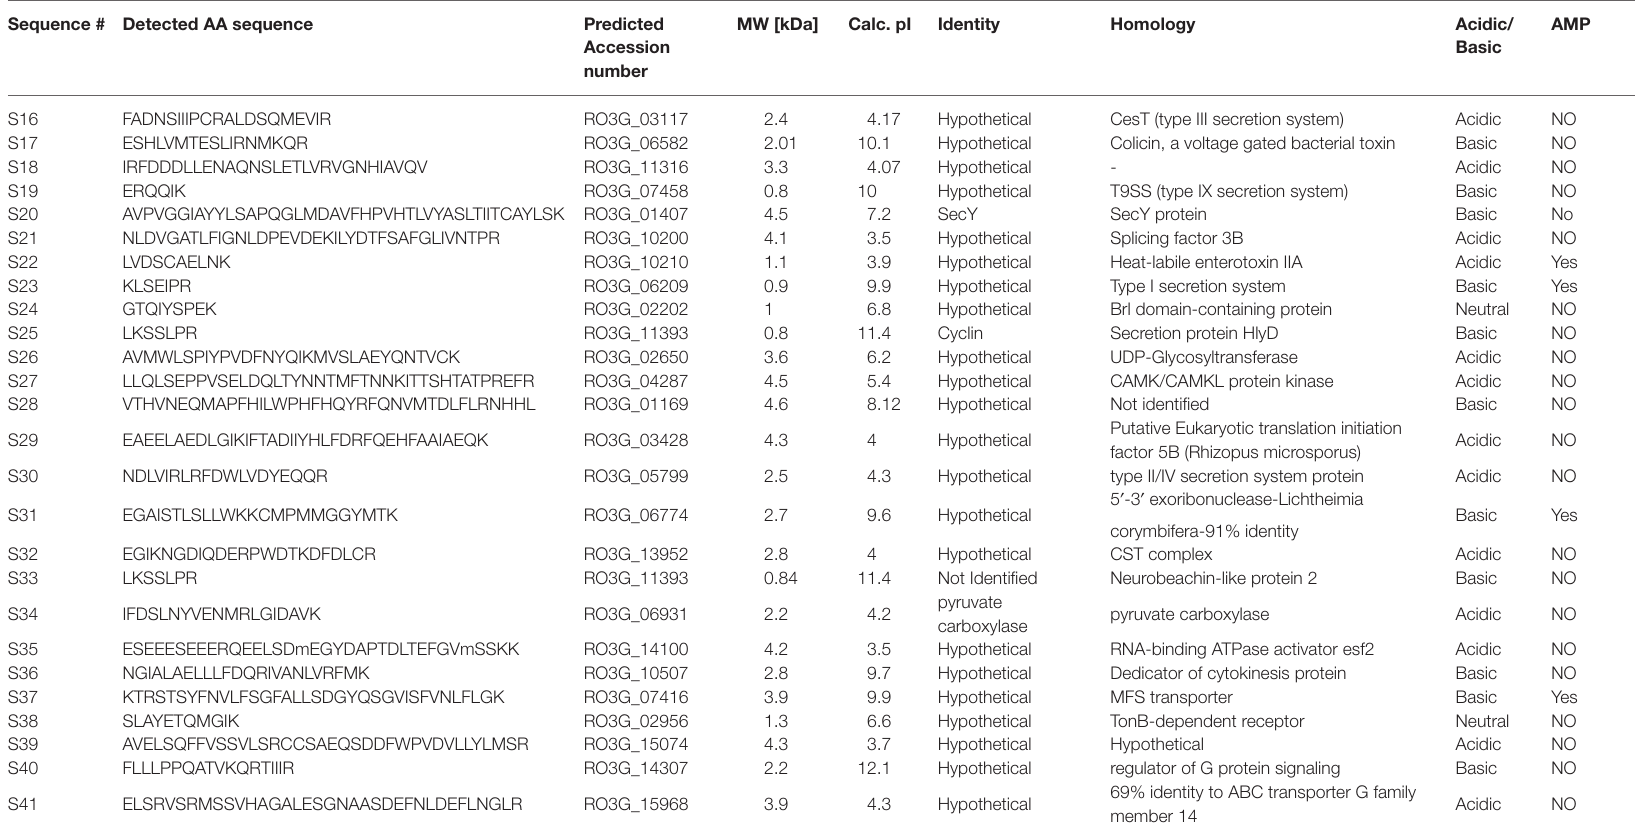
TABLE 3 | Identification of peptides sequences by LC–MS/MS in the supernatant of R. arrhizus var. delemar fungus growing at dissemination-like condition compared to control culture media without the fungus. Sequence # Detected AA